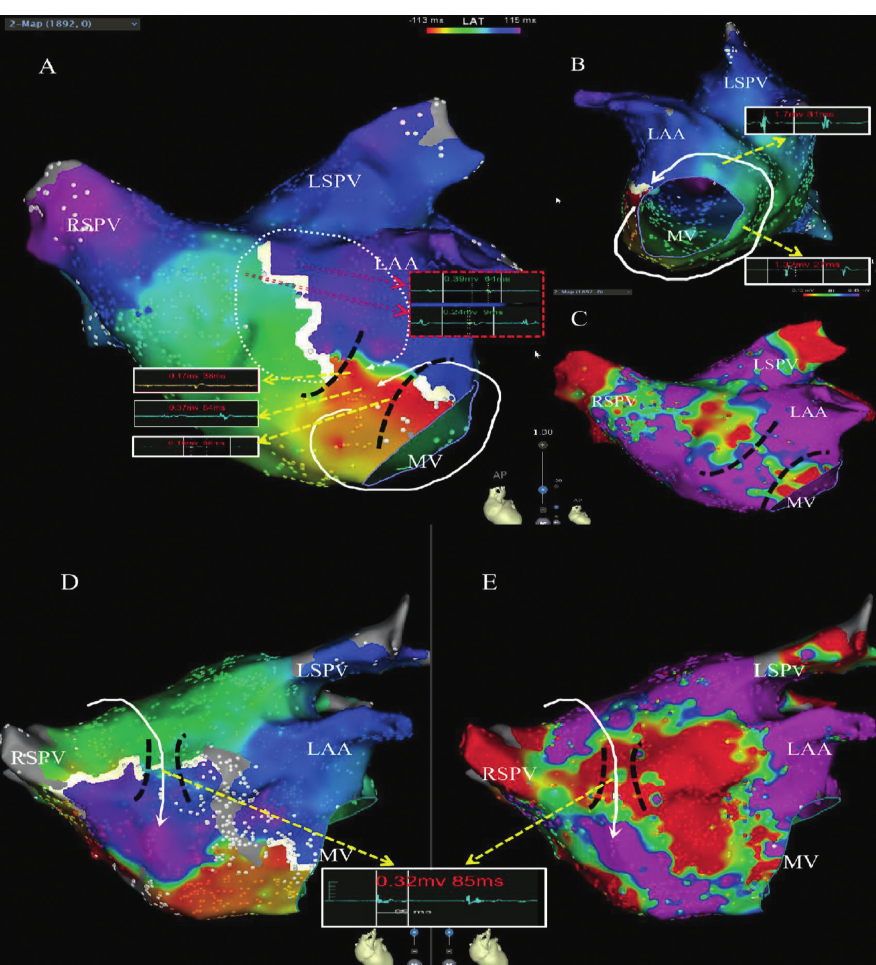
Figure 2: The electrophysiological characteristics of arrhythmogenic substrate. Left atrial activation maps of a patient (a–c) with a double- loop reentry by a critical isthmus (a, c, black dotted lines), which is shown through early meet late in CARTO 3 V6 (action time of more than 25 percent of the TCL between adjacent points indicates block lines (a, red boxes)). The electrograms and conduction velocities of isthmus are shown and selected for ablation (a, white boxes). In contrast, the conventional anatomical isthmus located at the mitral isthmus exhibited normal electrogram characteristics (b, white boxes). The voltage maps (purple ≥ 0.45mV; red: < 0.1mV) characterized by a central scar at the mid anterior level (c, e). A patient presented with single-loop reentry, and a clockwise loop revolved around the right pulmonary vein (d, e). The isthmus (black dotted lines) located between LAAW scar and the roof adjacent to the RSPV. Tachycardia was terminated in 10 seconds by ablation of the isthmus, where it showed a conduction slowing highly fractionated electrograms (d, e, white boxes) (see Supplementary Material Video 1,2). LAA: left atrial appendage; MV: mitral valve; LSPV: left superior pulmonary vein; RSPV: right superior pulmonary vein; RPV: right pulmonary vein; LAAW: left atrial anterior